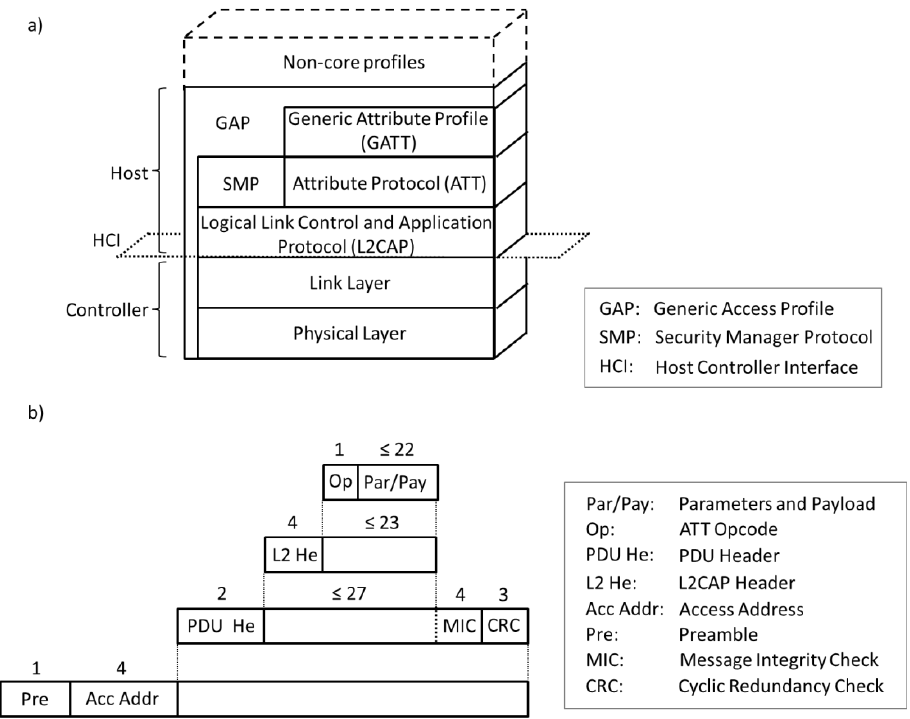
Figure 1. ( a ) BLE protocol stack; ( b ) structure of a BLE data unit (note: the size of each field is expressed in